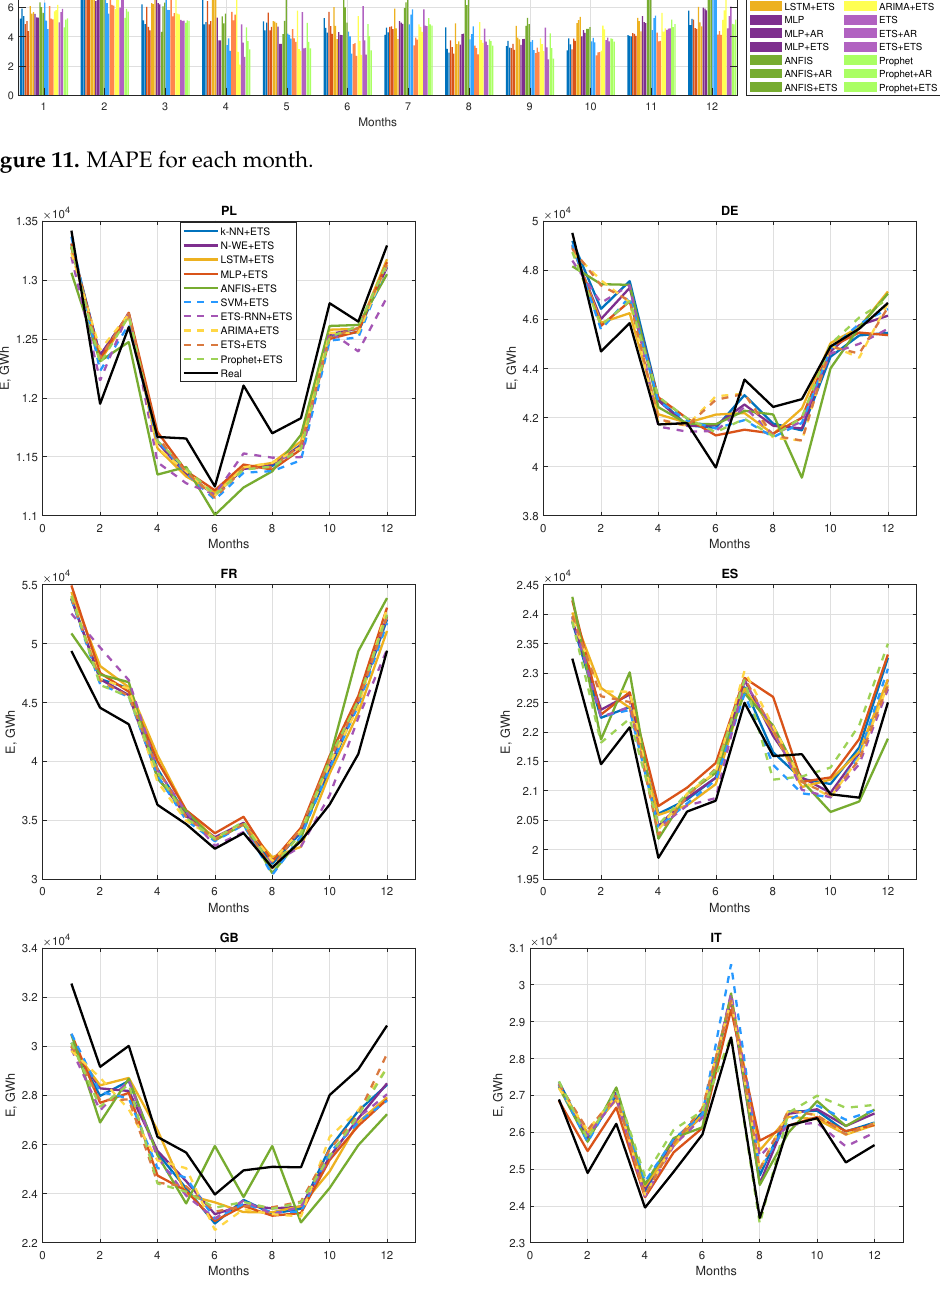
Figure 12. Examples of forecasts of